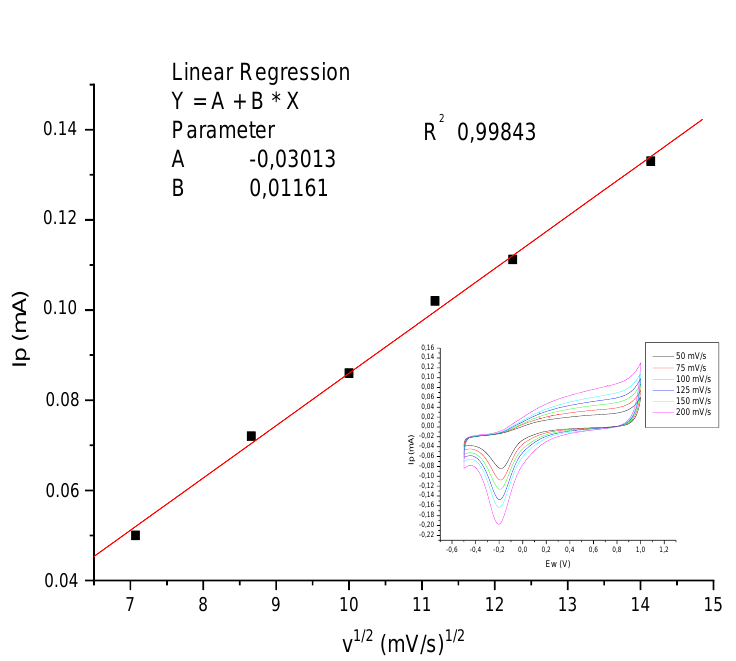
Figure 8. CV voltammograms of 1.0 × 10 − 6 M AMD in PBS at pH 7.4 on Pt-modified electrode for series of scan rates from 50 to 200 mV s − 1 .